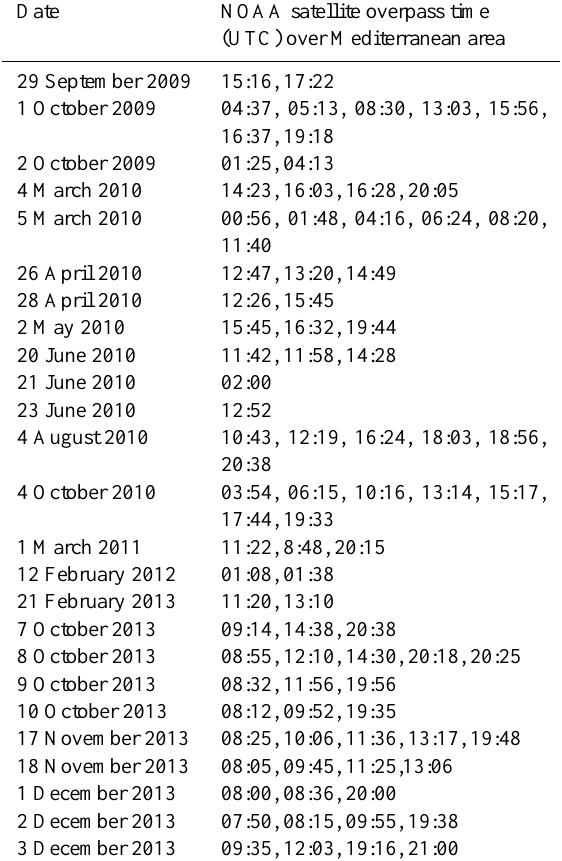
Table 1. List of the NOAA satellite overpasses for the AMSU-B PEMW rain rate maps considered in the training